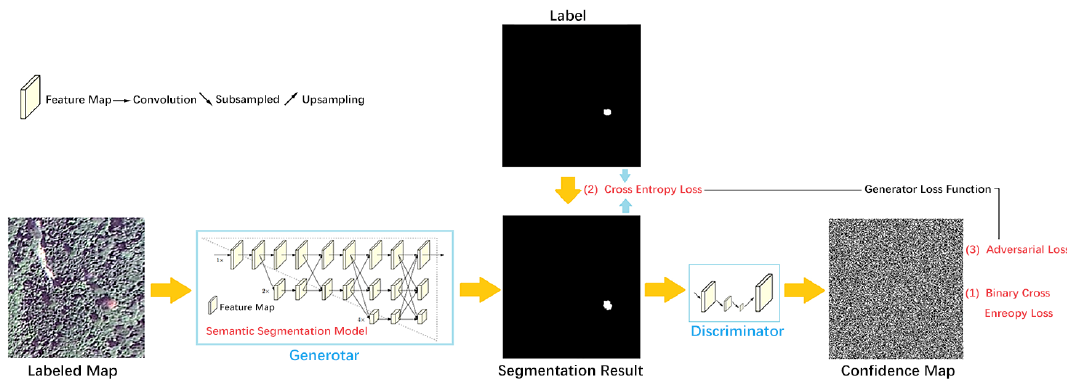
Figure 2. GAN-based supervised semantic segmentation model.